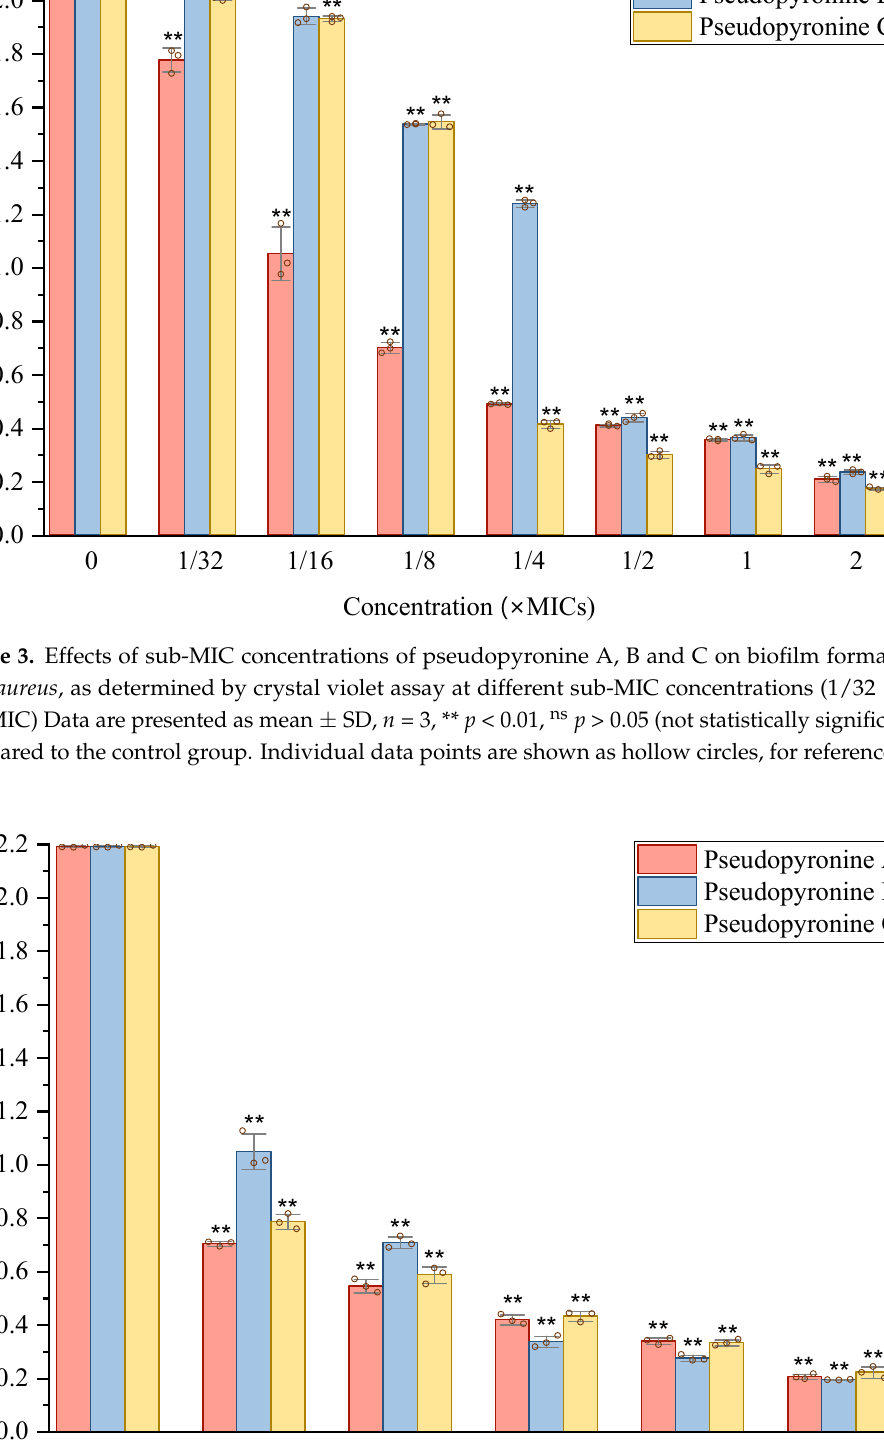
Figure 5. Reduction effects of sub-MIC concentrations of pseudopyronine A, B and C on metabolic activity of S. aureus evaluated by the MTT assay (1/2 × to 8 × MIC). Data are presented as mean ± SD, n = 3, * p < 0.05, ** p < 0.01, compared to the control group. Further investigations were carried out using confocal microscopy. 3D biofilm im- ages of mature biofilms, produced with different sub-MIC concentrations of the three